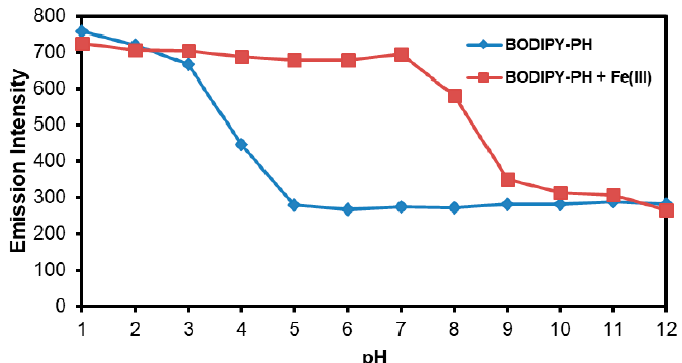
Figure 10. Fluorescence intensity variation at maximum emission of 518 nm of BODIPY-PH (10 µ M) at media alternation of pH from 1 to 12.